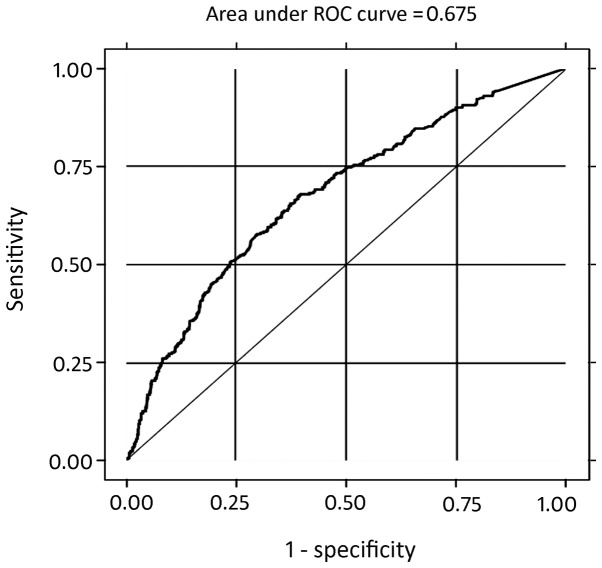
ROC analysis of the logBNP levels for determining the incidence of clinical compound endpoint events in all the patients (AUC, 0.6752; standard error, 0.01698; 95% confidence interval, 0.64198–0.70835). The cut-off value was determined to be 100 pg/ml (specificity, 70.16%; sensitivity, 57.44%). ROC, receiver operating characteristic; BNP, brain natriuretic peptide; AUC, area under curve.